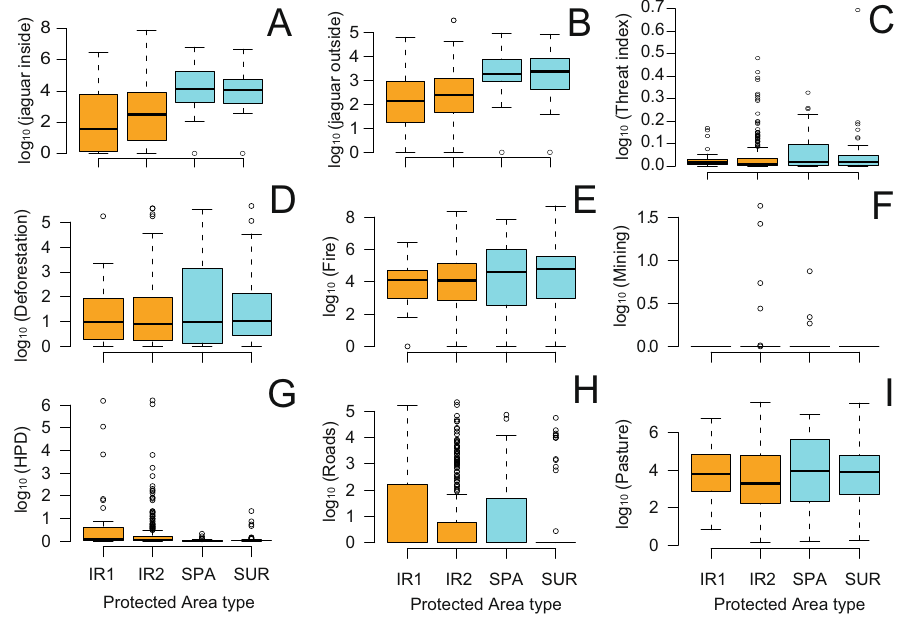
Fig. 2 Threats to jaguar across Amazonian protected areas. Jaguar population sizes inside protected areas ( A ), jaguar population sizes outside protected areas (5 km buffer; B ), threat index (TI; C ), deforestation (km 2 ; D ), fi re hotspots (N; E ), mining areas inside (km 2 ; F ), human population density (persons/ km 2 ; G ), roads (km, H ), and exotic cattle pastures (km 2 , I ) across 447 protected areas grouped by legal status across the Brazilian Amazon. SPA Strictly Protected Conservation Units, SUR Sustainable Use Conservation Units (SUR), IR1 declared Indigenous Reserves, IR2 Indigenous Reserves that have been demarcated, approved, or legally sanctioned. All data are log 10 -transformed and from C to H are the sum of values both inside and outside protected areas.